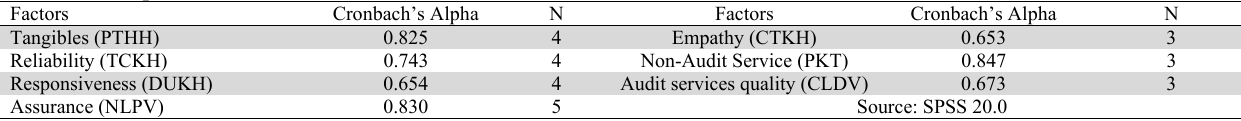
Cronbach’s Alpha coefficient